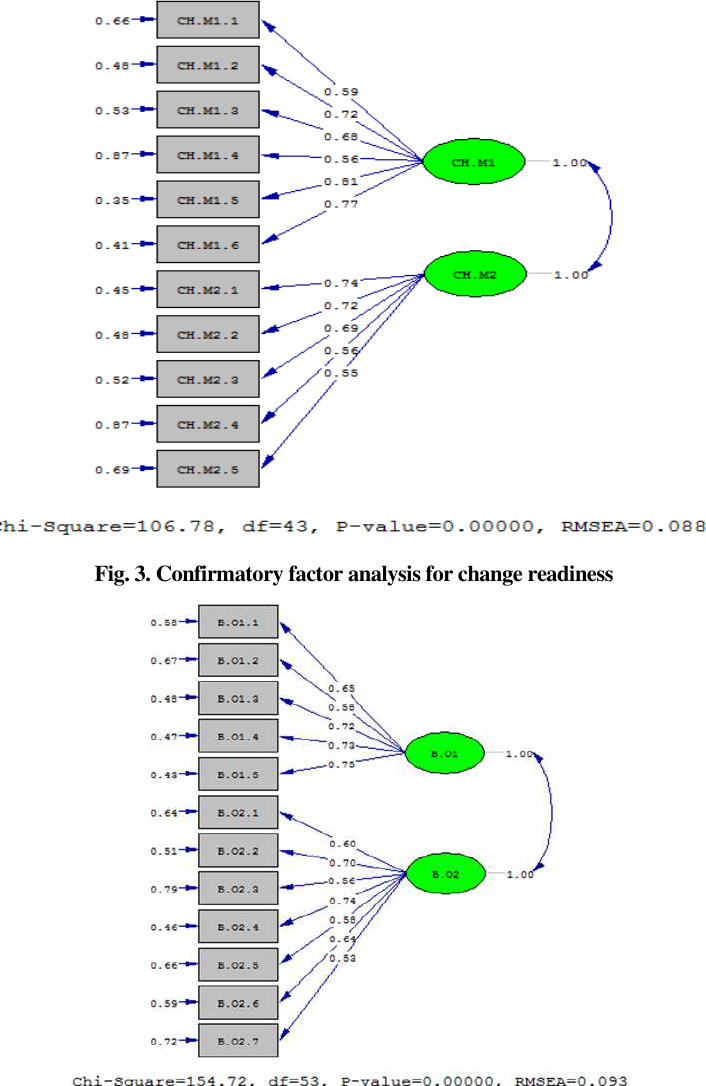
Fig. 4 Confirmatory factor analysis for bureaucratic